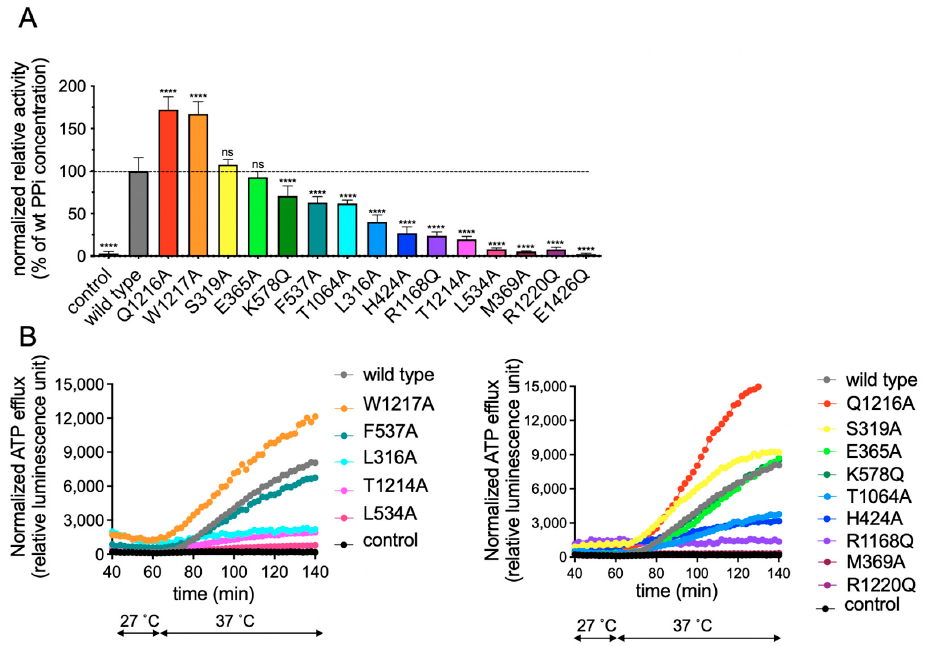
Figure 4. Activity of rAbcc6 mutants in HEK293 cells. ( A ): PPi accumulation in culture medium and ( B ): ATP efflux from cell lines overexpressing rAbcc6 in which amino acid residues corresponding to those forming the bAbcc1 LTC 4 binding cavity were mutated. Data are presented as means ± SD for ( A ). For ( B ), means of representative experiments, each with at least 4 replicates are shown. In ( B ) data are presented in two graphs to better see results of individual mutants. Wild type: wild ‐ type rAbcc6, control: parental HEK293 cells. The dashed line in ( A ) indicates the average amount of PPi in medium of HEK293 cells overproducing wild ‐ type rAbcc6, which was set at 100%. Values have been adjusted to take any differences in protein expression of the mutants relative to wild type rAbcc6 into account. The same color coding was used for each mutant in panels A and B. **** p < 0.001 (ANOVA and subsequent Dunnett’s multiple comparison test). Changes were considered biologically relevant when reduced by >50% compared to wild ‐ type rAbcc6.